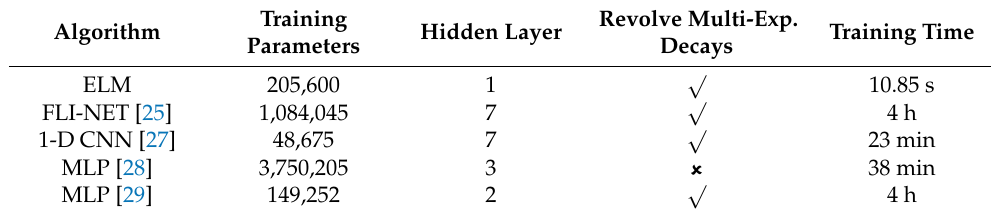
means the algorithm cannot resolve multiple-